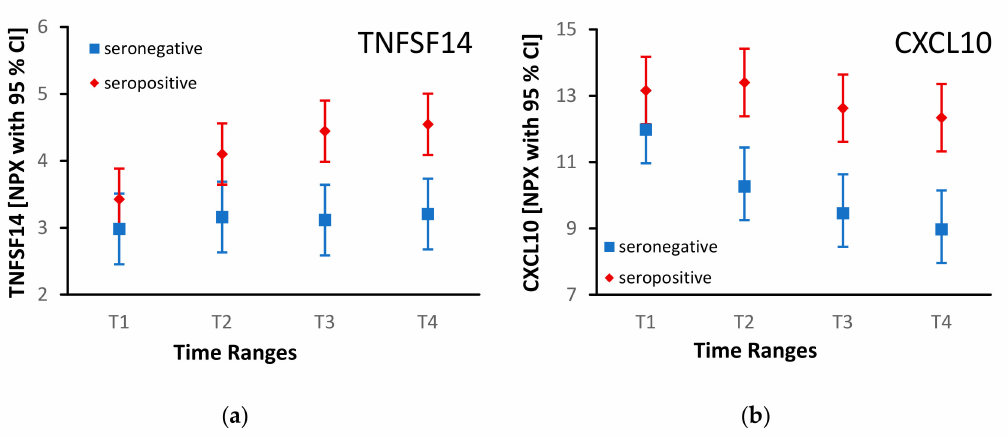
Figure 3. Longitudinal TNFSF14 ( a ) and CXCL10 ( b ) levels [Normalized Protein Expression; mean with 95 % confidence interval (CI)] in four IgG-seropositive (red) and three IgG-seronegative